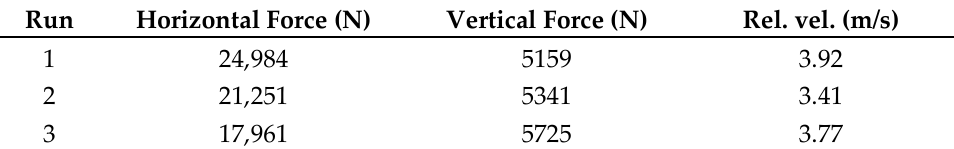
Table 3. Horizontal and vertical forces measured by RMT_AX and RMT_BE bridges at max